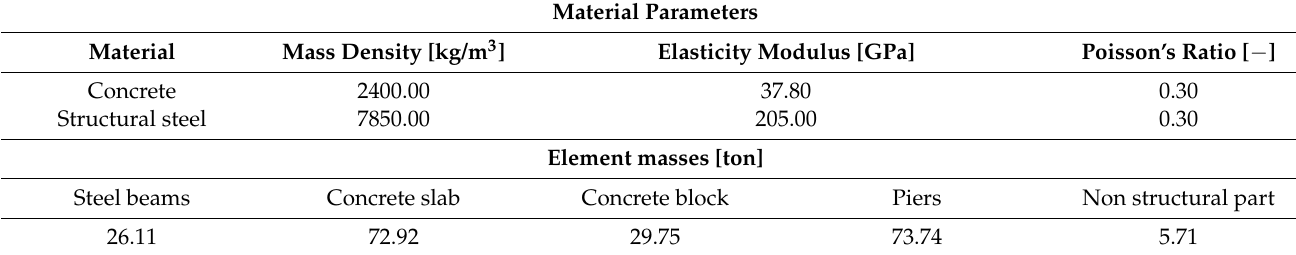
Table 1. Material parameters and element masses of the